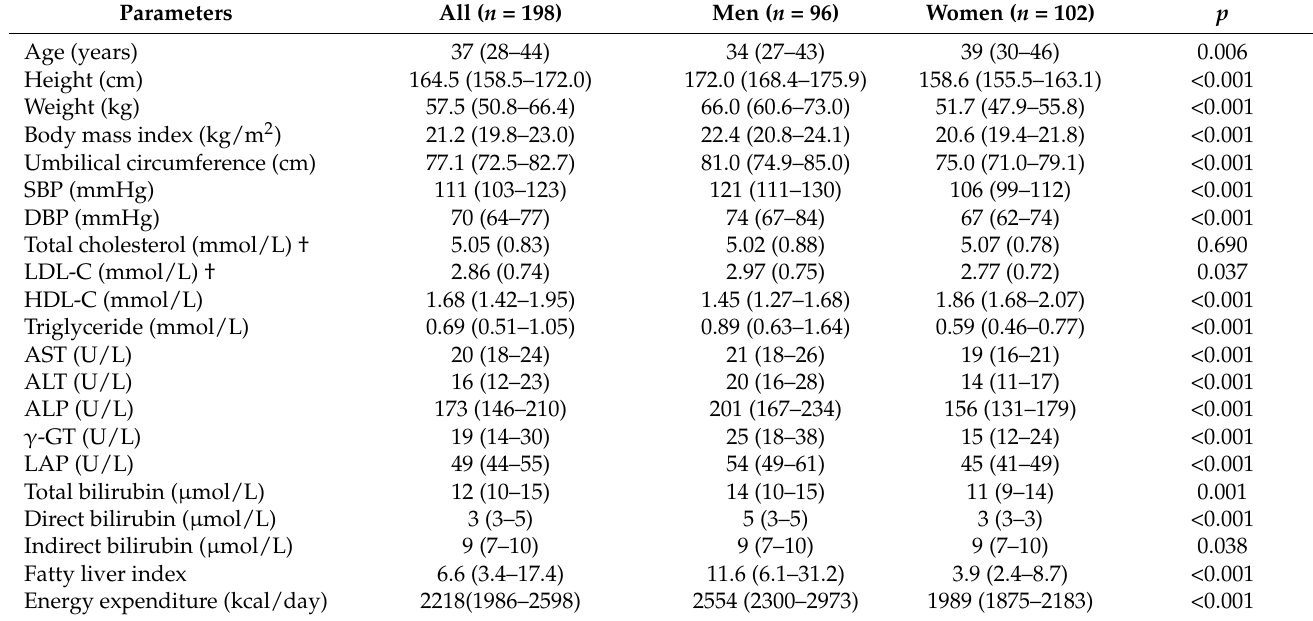
Table 1. Characteristics of